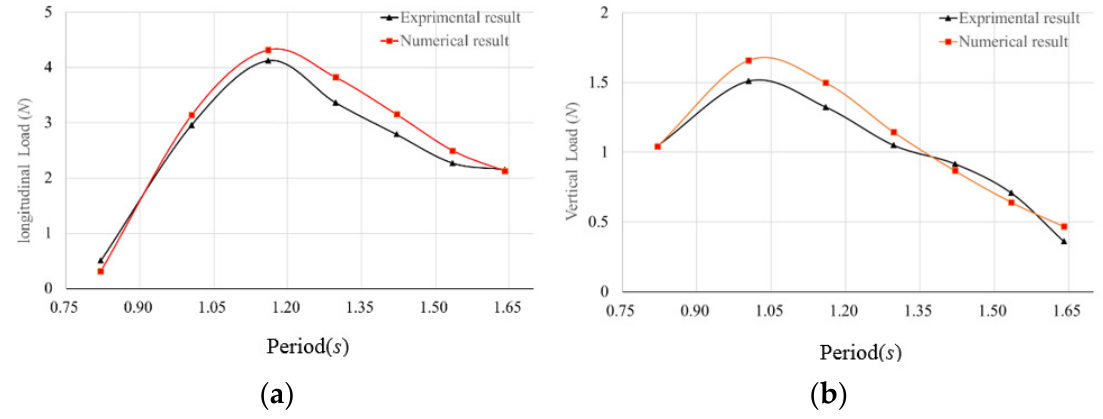
Figure 12. Loads on the hinged connector: ( a ) longitudinal load; ( b ) vertical load.